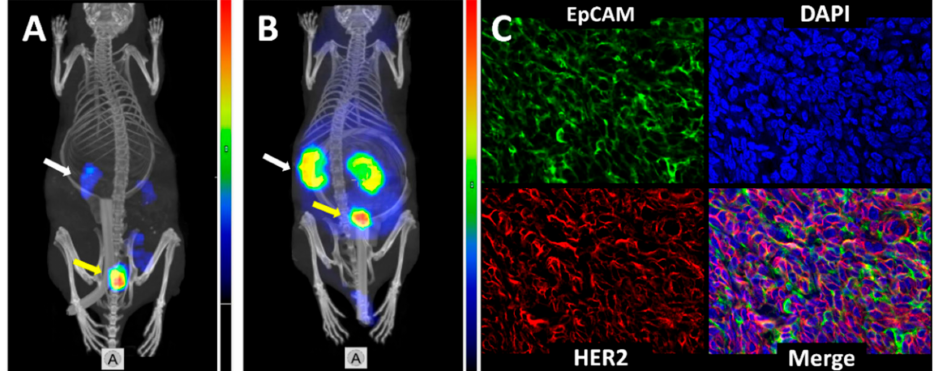
Figure 7. Micro-single photon emission computed tomography (SPECT)/CT imaging of ( A ) EpCAM expression using [ 125 I]I-PIB-Ec1 at 6 h pi;( B ) HER2 expression using [ 99m Tc]Tc-ZHER2:V2 at 4 h pi in BALB/c nu/nu mice bearing SKOV3 xenografts. White arrows point at kidneys, yellow arrows point at tumors. Co-expression of HER2 and EpCAM in SKOV-3 xenografts ( C ). EpCAM is stained green, HER2 is stained red, nuclei were counterstained with DAPI (blue) (200 ×